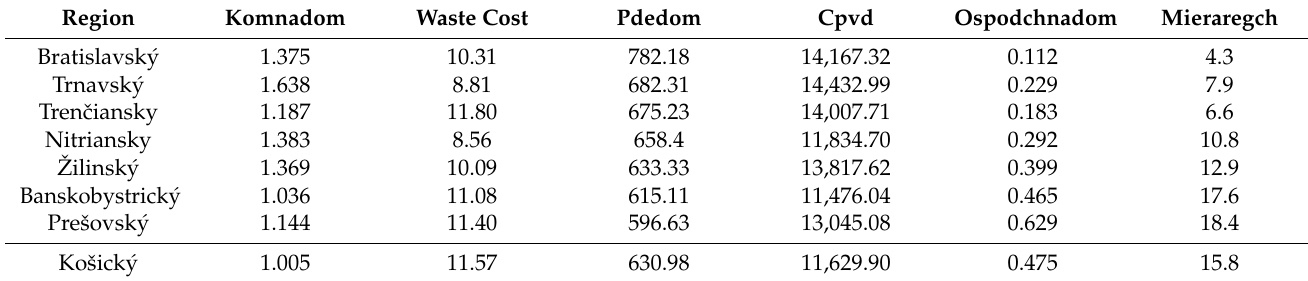
Table 9. Input data in 2018.